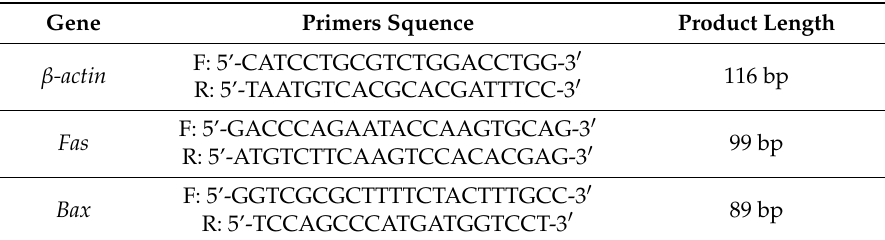
Table 1. Primers Used for Quantitative Reverse Transcription